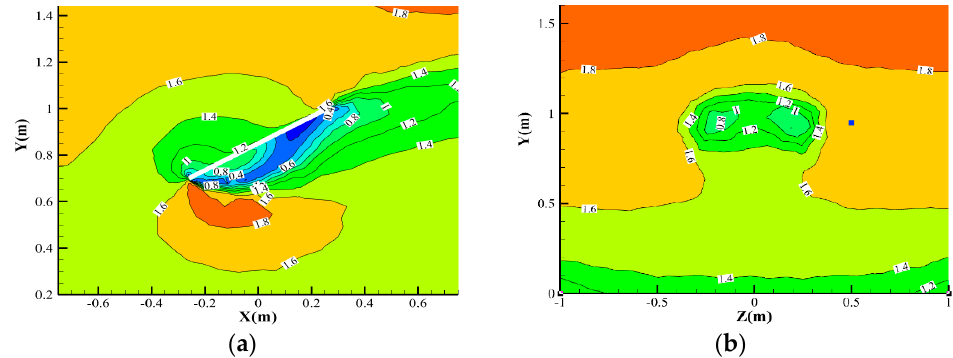
Figure 5. Velocity distribution around solar panel on different contour surfaces when u ∗ = 0.1 ms − 1 . 1 ( a ) z = 0 m ( b ) x = 0.5